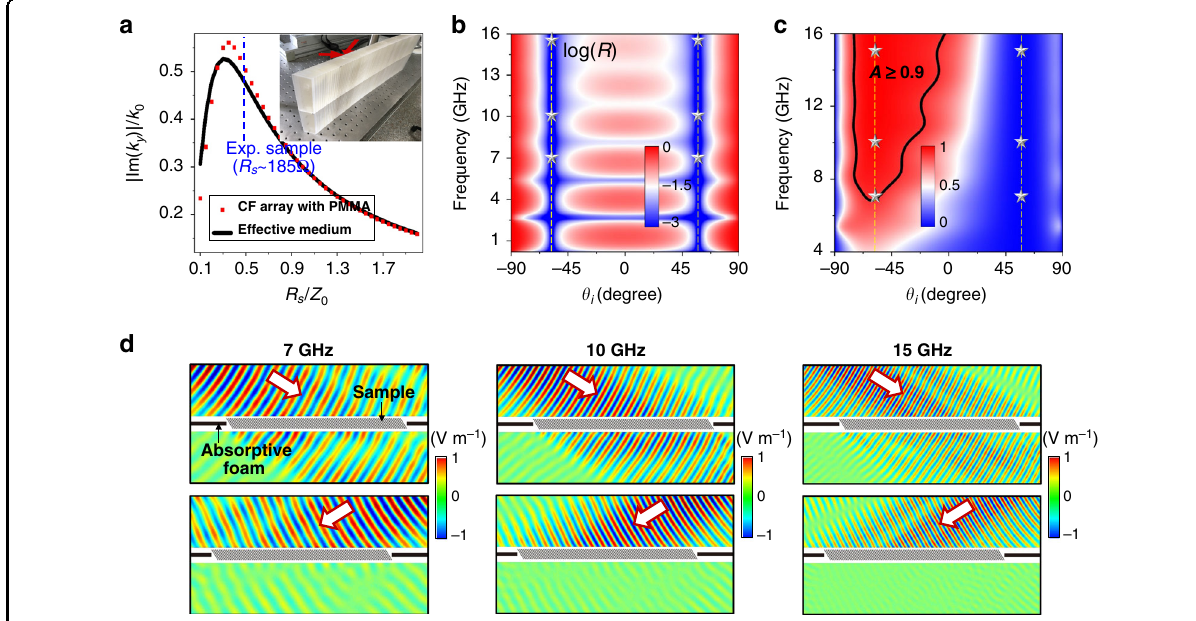
(cid:5) (cid:3) (cid:4)(cid:5) (cid:5) (cid:5) in the CF array